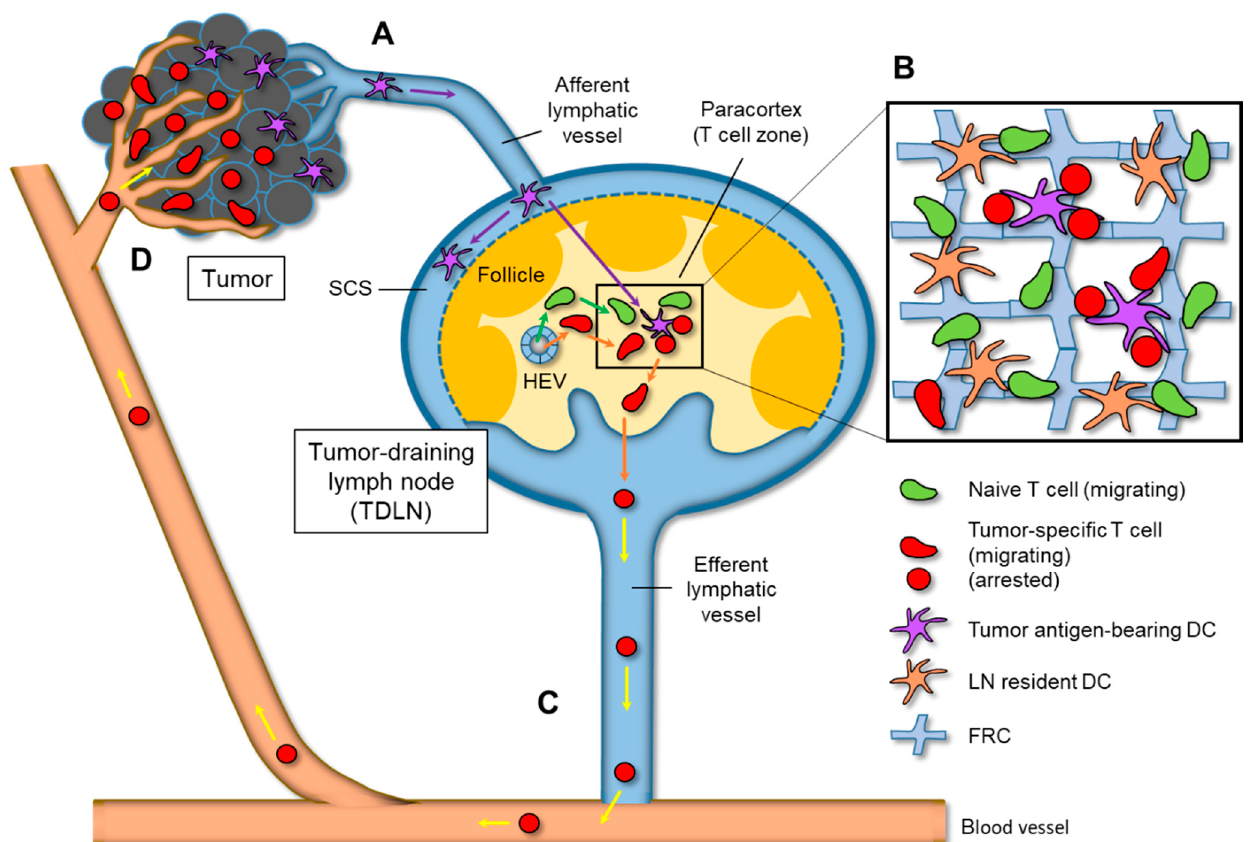
Figure 1. Immune cell trafficking in antitumor responses and motility changes in tumor ‐ draining lymph nodes (TDLNs). ( A ) CCR7 ‐ expressing DCs that internalize tumor antigens in primary tumor migrate to TDLNs via afferent lymphatic vessels. Tumor antigen ‐ bearing DCs reach the subcapsular sinus, followed by entry into the paracortical T zone. ( B ) Naive T cells that enter the paracortex via HEVs exhibit random migration in the interstitial space constructed by the fibroblastic reticular cell (FRC) meshwork and dendritic cells (DCs) when searching for antigens presented by DCs. When antigen ‐ specific CD8 + T cell encounter CD103 + DCs (cDC1) displaying cognate antigens, they are arrested on the DC surface, forming an immunological synapse. After activation with sufficient TCR ‐ dependent signaling, the motility of T cells is restored. ( C ) Activated/effector T cells or memory T cells leave the TDLN through the efferent lymphatic vessel and recirculate in the bloodstream. ( D ) Tumor antigen ‐ specific CD8 + T cells transmigrate across tumor blood vessels into peri ‐ tumoral region and infiltrate the tumor core region, where they kill tumor cells.